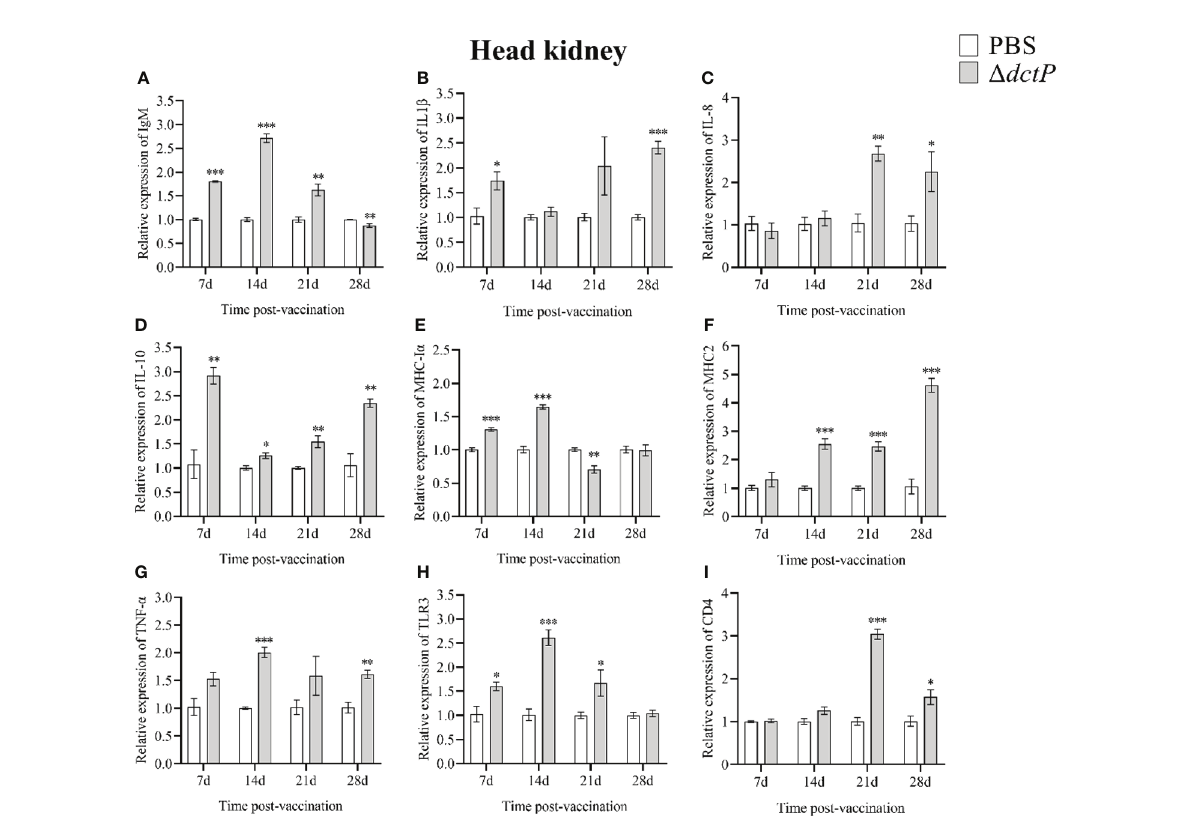
FIGURE 5 The expression levels of immune-related genes in the head kidney of pearl gentian groupers by qRT-PCR post-immunization. The mRNA level of each immune-related gene was normalized to that of b -actin and relative expression was calculated as the values of the vaccinated tissues by those of the controls. (A) IgM , (B) IL-1 b , (C) IL-8 , (D) IL-10 , (E) MHC-I a , (F) MHC2 , (G) TNF- a , (H) TLR3 , and (i) CD4 . Bars represented the mean relative expression (n=3) and error bars represent standard errors. The asterisks indicated signi fi cant differences: *(p < 0.05), **(p < 0.01) and ***(p < 0.001), between PBS group and D dctP